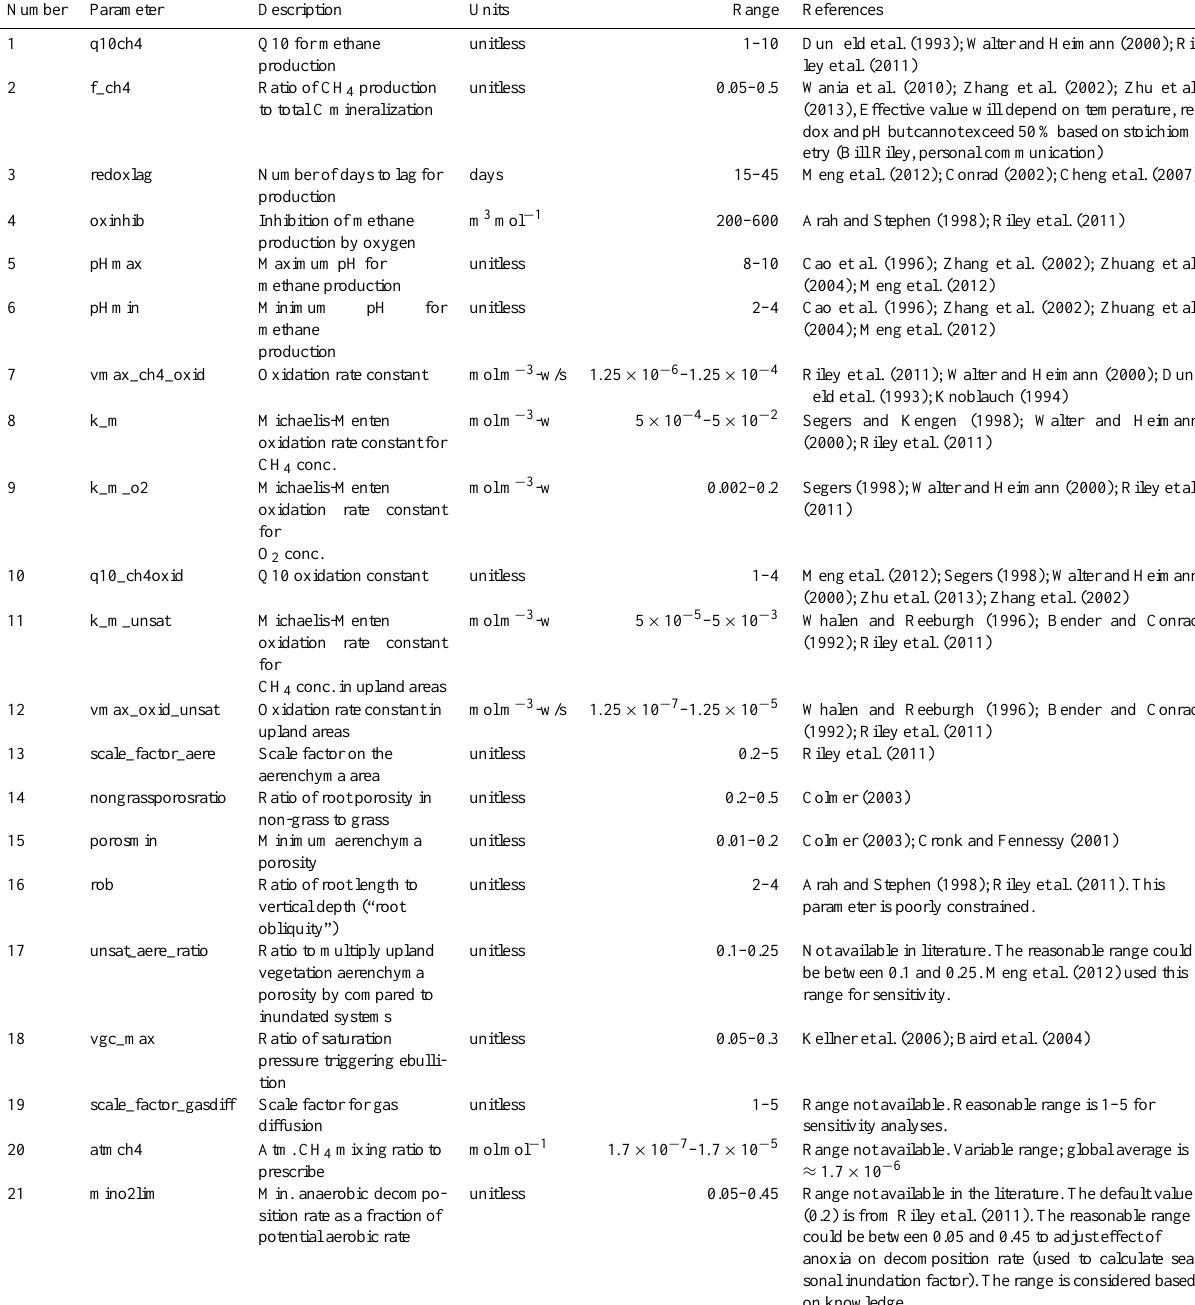
Table C1. Parameter names, descriptions, ranges, and literature